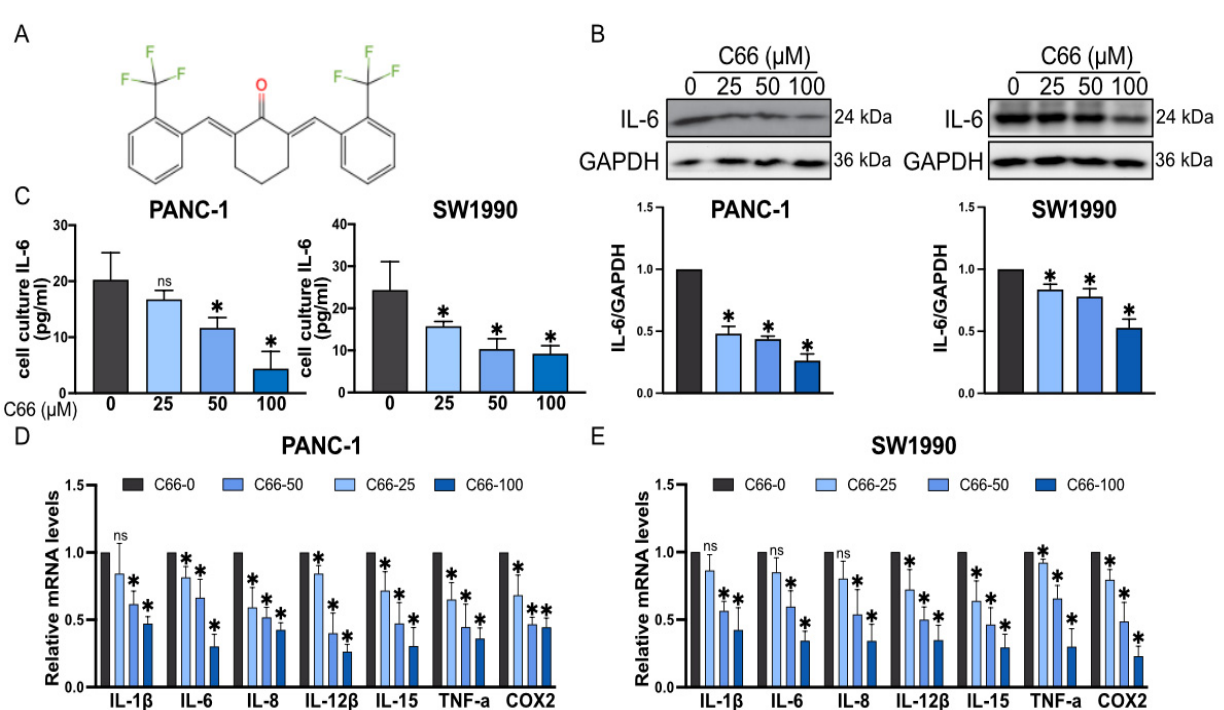
Figure 2. Inhibition of inflammatory factors by C66. ( A ) Structure of C66. ( B ) PANC-1 and SW1990 were treatment of with C66 (25, 50, and 100 µ M) for 24 h. Protein levels of IL-6 were detected by Western blot. GAPDH was used as control. Densitometric quantification is shown in lower panel. Each bar represents mean ± SEM of three independent experiments. n = 3, * p < 0.05, compared with the matching control. ( C ) Levels of IL-6 in PANC-1 and SW1990 conditioned culture media as de- termined by ELISA. Cells were treated with C66 and IL-6 levels in media were measured at the indicated dose for 24 h. Each bar represents mean ± SEM of three independent experiments. n = 3, * p < 0.05, compared with the matching control; ns = not significantly different, compared with the matching control. ( D , E ) IL-1 β , IL-6, IL-8, IL-15, TNF- α , and COX2 mRNA expression after the treat- ment of PANC-1 and SW1990 with C66 (25, 50, 100 μ M) by RT-qPCR. Each bar represents mean ± SEM of three independent experiments. n = 3, * p < 0.05, compared with the matching control; ns = not significantly different, compared with the matching control.